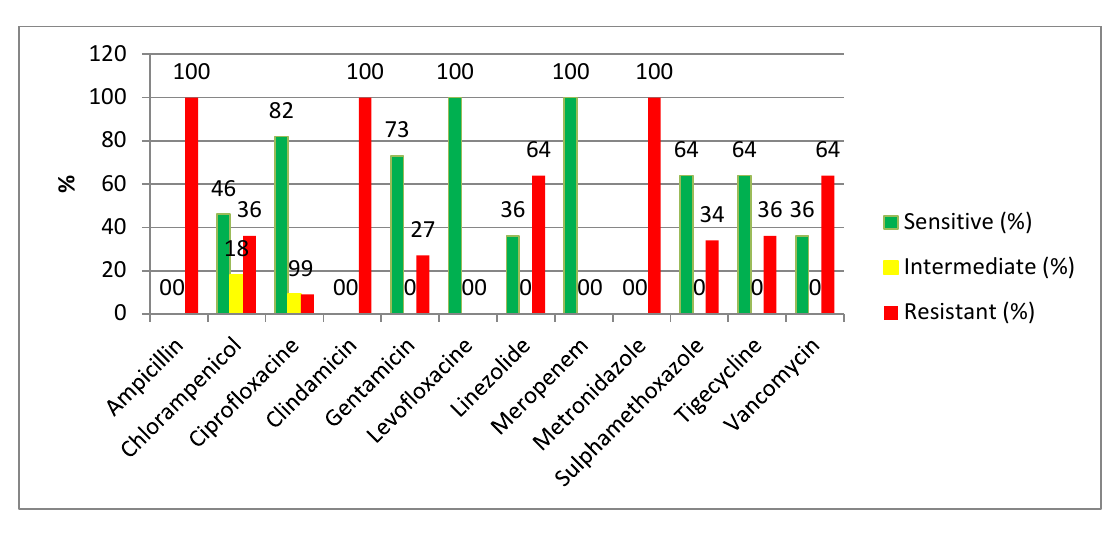
Fig. 1. Antibiotic sensitivity pattern of alpha-hemolytic streptococcus (n=11).